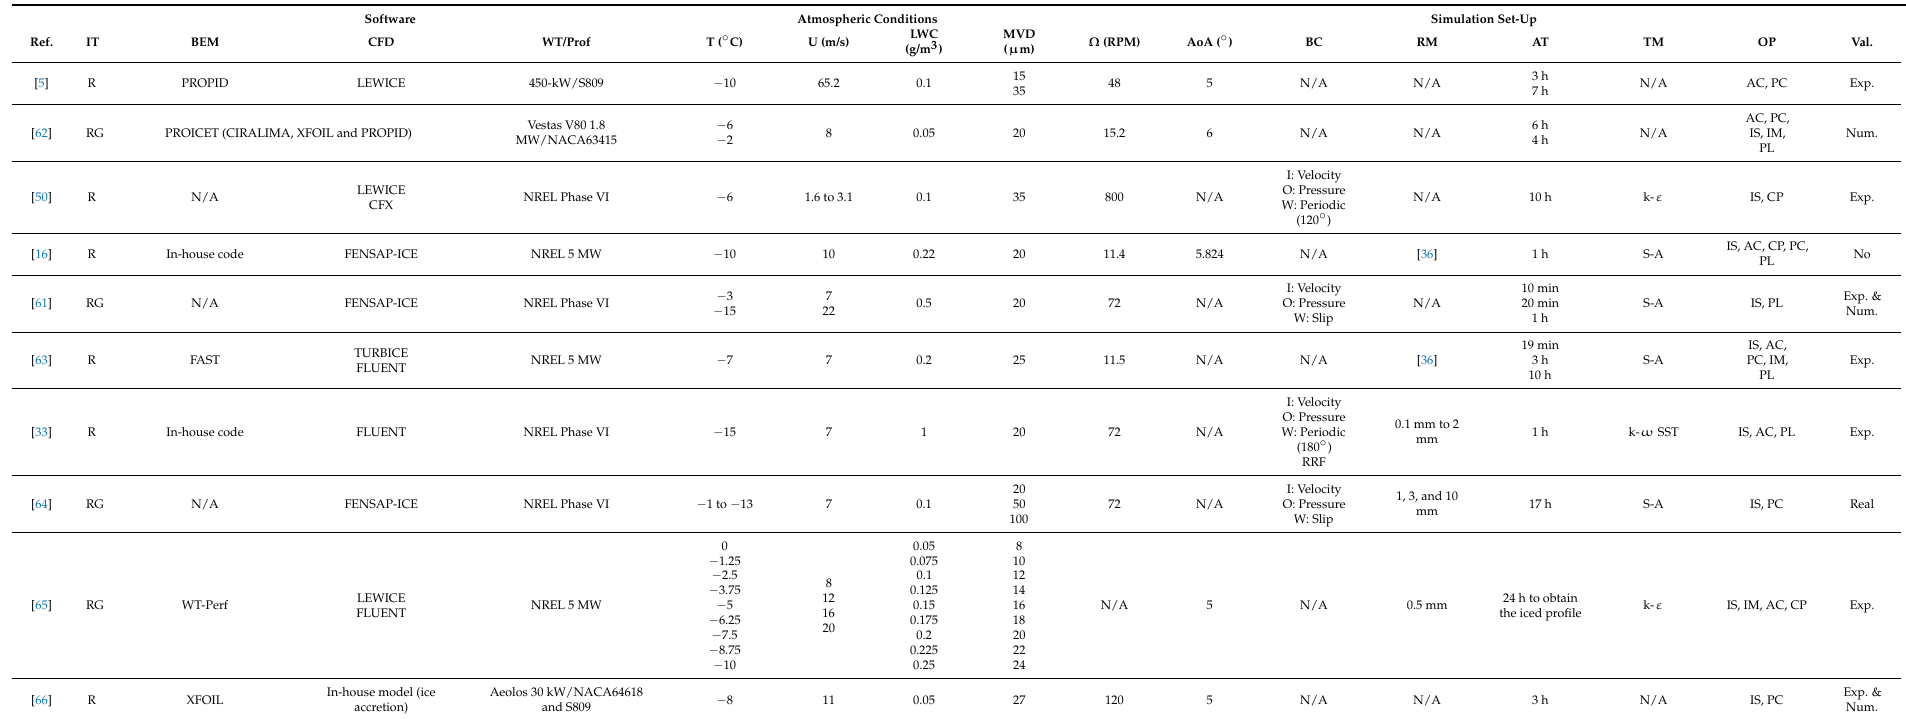
Table 1. Summary of the setup of each